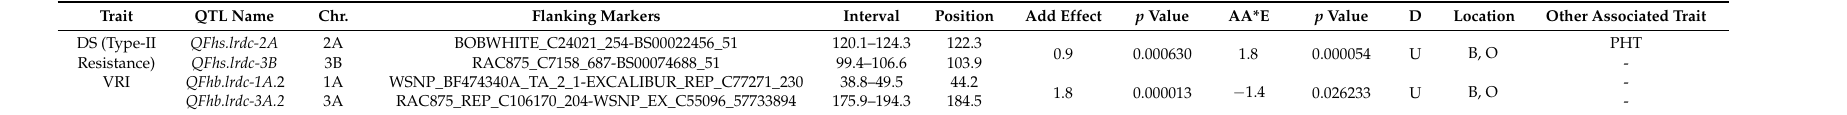
Table 5. Summary of epistasis QTL for DS and VRI identified during the present study.